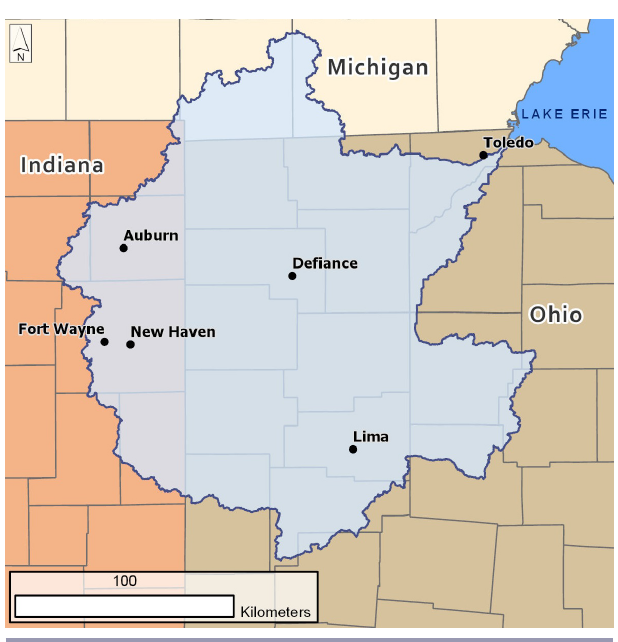
Fig. 1 . The Maumee River